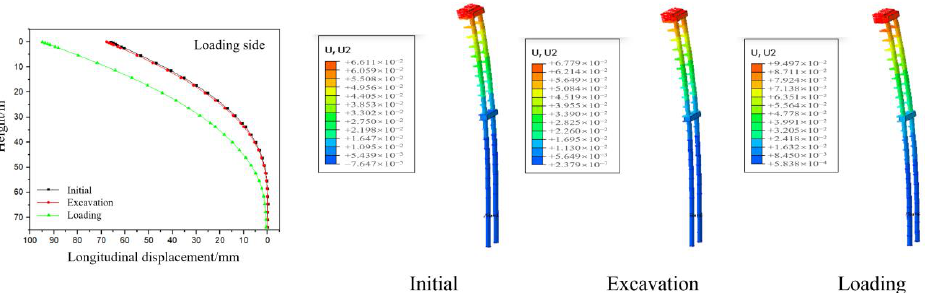
Figure 21. Displacement of Pier P30 under asymmetric filling soil load (m).